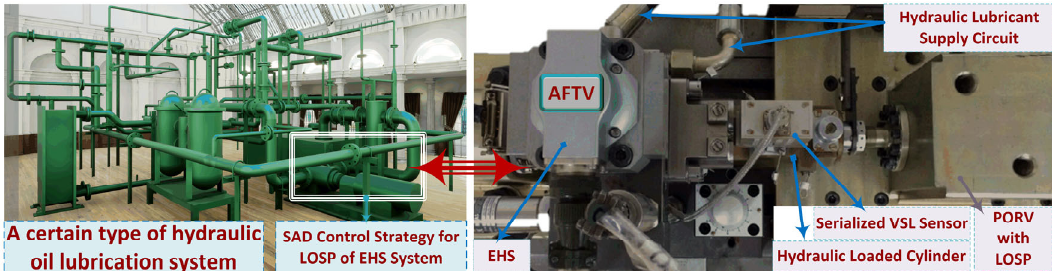
Figure 11. The EHS system experiment platform.